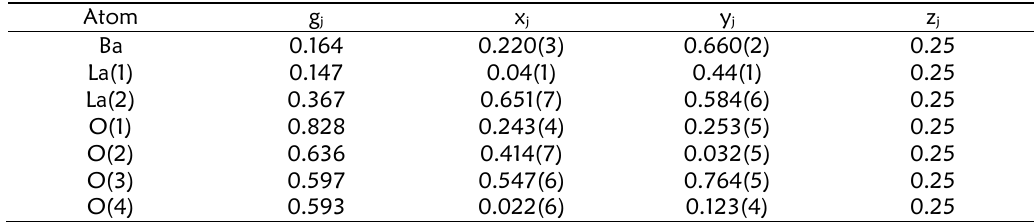
Table 13. The coordinates of atomic fractions (x j , y j , z j ), and atomic occupancy factor (g j ) of BaLa 2 O 4 phase based on neutron diffraction